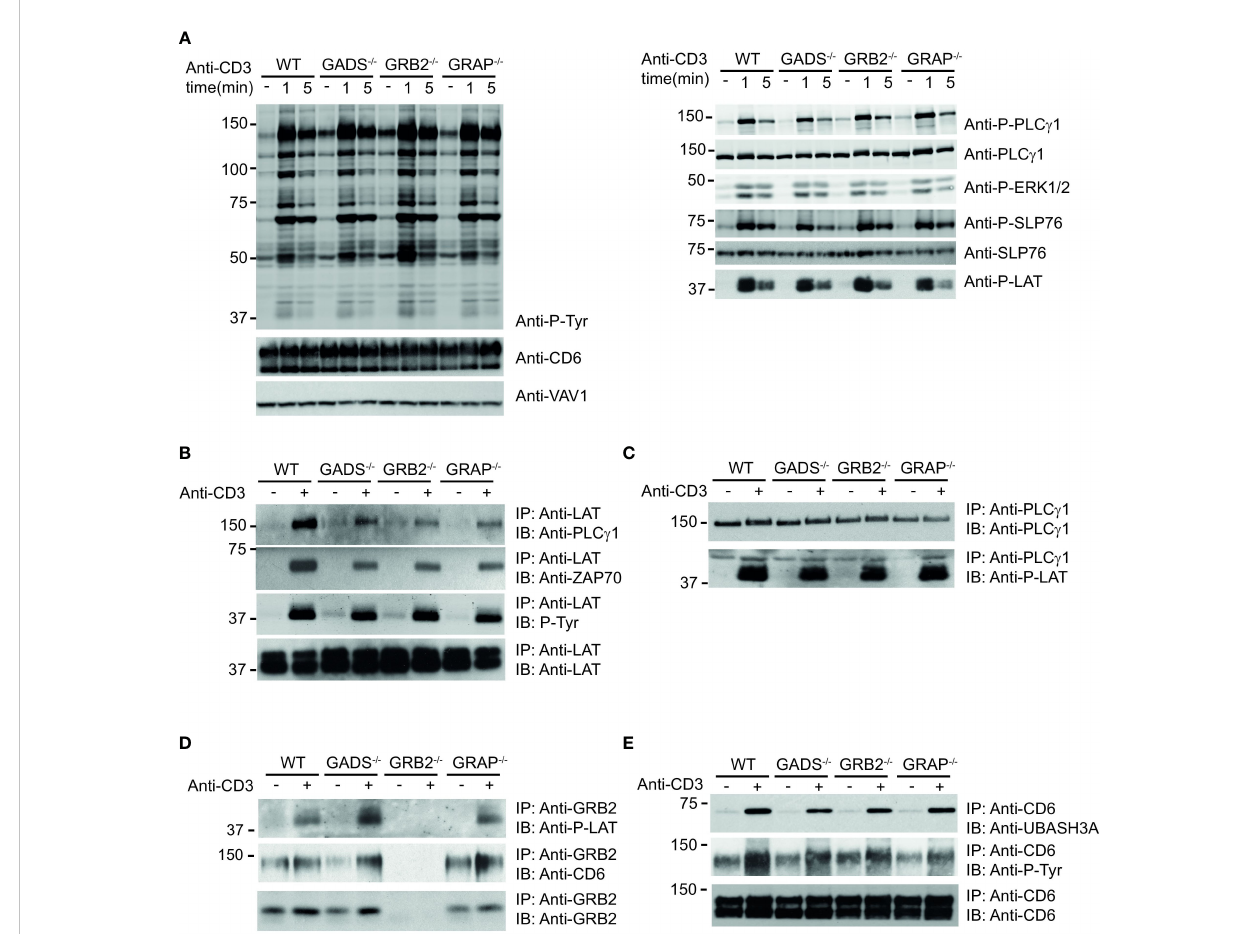
FIGURE 3 Analysis of TCR-induced molecular events in cells de fi cient in GRB2-family adaptors. (A) WT, GADS -/- , GRB2 -/- and GRAP -/- Jurkat cells were left unstimulated (-) or stimulated for 1 or 5 min with anti-CD3 antibody. Equal amounts of protein lysates were analyzed by immunoblot with phospho- speci fi c antibodies for tyrosine motifs (P-Tyr), ERK1/2 (T202/Y204), SLP76 (Y128), PLC g 1 (Y783) and LAT (Y191). VAV1 and total proteins serve as a loading control (left and right panel respectively). The CD6 expression was also assessed for each Jurkat variants. (B – E) The same cells as in (A) were left unstimulated (-) or stimulated (+) with anti-CD3 antibody and subsequently lysed. Equal amounts of cell lysates were incubated with the speci fi ed antibodies (IP) and the resulting immunoprecipitates analyzed by immunoblot with the antibodies speci fi ed in the left margin (IB). Data are representative of at least two independent